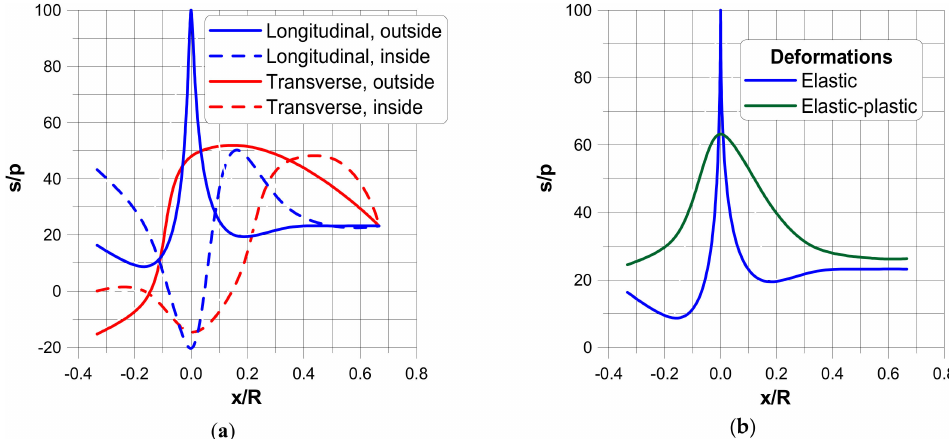
Figure 7. Stress distributions in a direction normal to the transverse and longitudinal planes. ( a ) elastic deformations. ( b ) comparison of elastic and elastic plastic stress